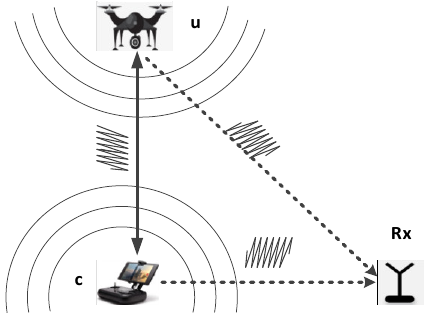
Figure 1. The system model which includes a signal source u , a controller c , and a passive receiver Rx. The dashed lines indicate that the receiver collects the signals passively, while the solid line represents the active communications between the source and controller.